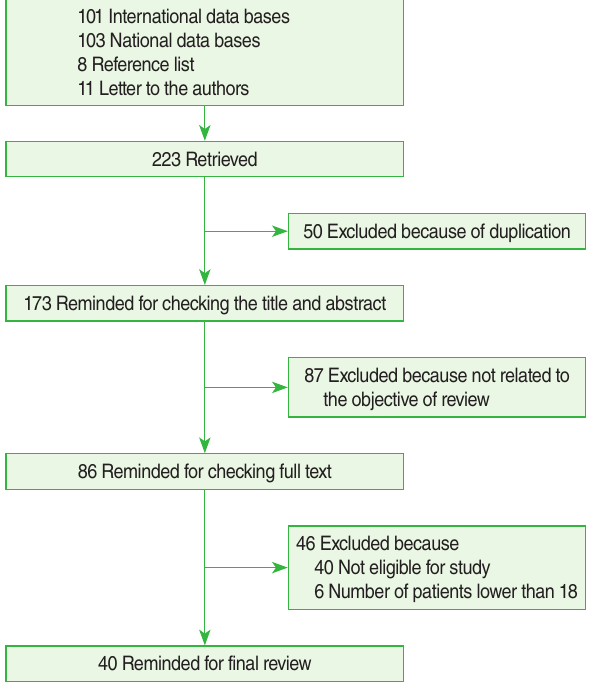
Figure 1. Flow diagram showing the phases of retrieving articles, checking eligibility criteria, and including the articles into the meta-